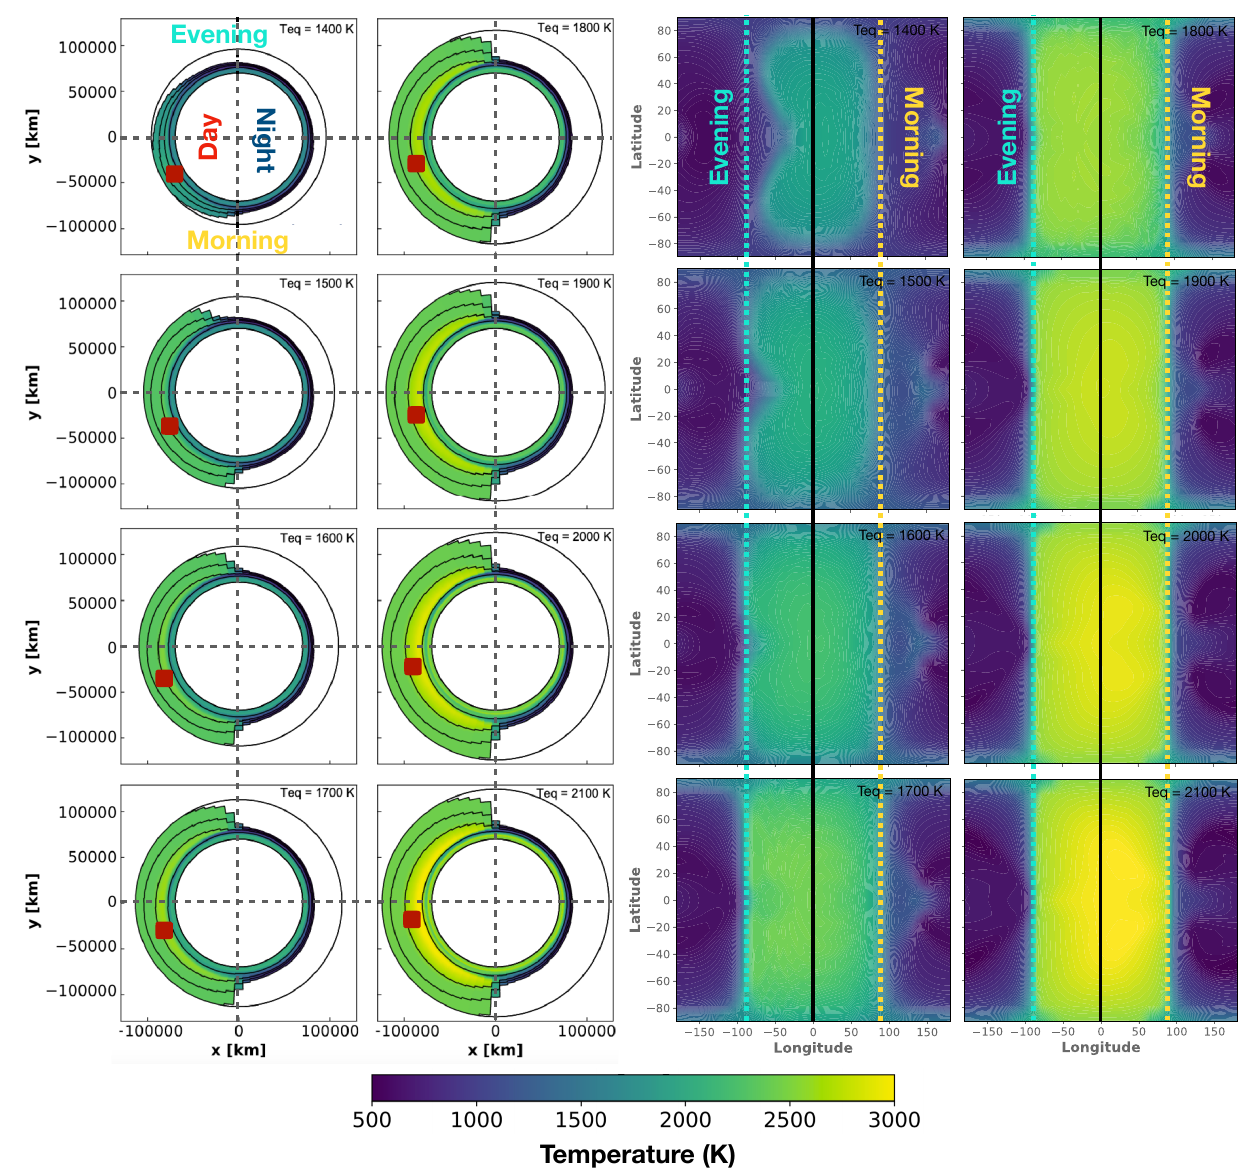
Figure 10. ( Left panels ) Equatorial cut of the temperature for 8 GCM simulations. From the center outward, the five solid black lines are the 1.434 × 10 7 , 10 3 , 1, 10 − 2 , and 10 − 4 Pa pressure levels. The hotter the equilibrium temperature, the larger the day–night thermal and chemical dichotomy. The red points show the hot spots of each simulation. ( Right panels ) Temperature map at 100 Pa of the corresponding GCM simulations. The black line shows the sub-stellar longitude. The blue and yellow dashed lines show the evening and the morning limbs, respectively. It thus highlights the hot spot shift and the limbs’ temperature asymmetries. The equilibrium temperature of the planet (ranging from 1400 to 2100 K) is specified. Figure adapted from Pluriel et al.